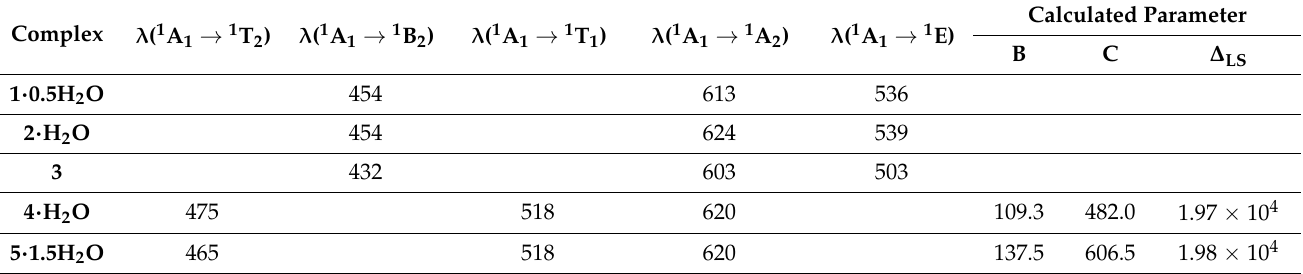
quadrupole doublets whose parameters correspond to the LS state of iron(II) (Figure